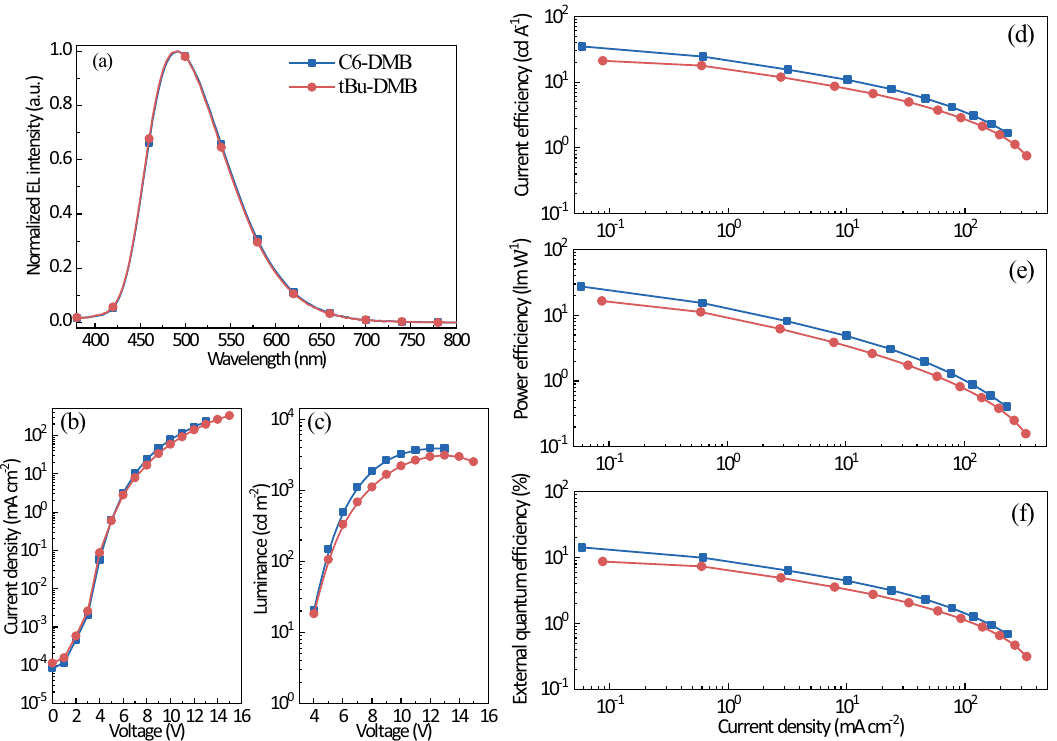
Fig. 6 Device performance of non-doped devices. a EL spectra; b current density to voltage curves; c luminance to voltage curves; d current ef fi ciency to current density curves; e power ef fi ciency to current density curves; f EQE to current density curves of non-doped